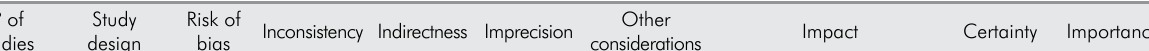
Table 5. Quality of evidence assessment according to the